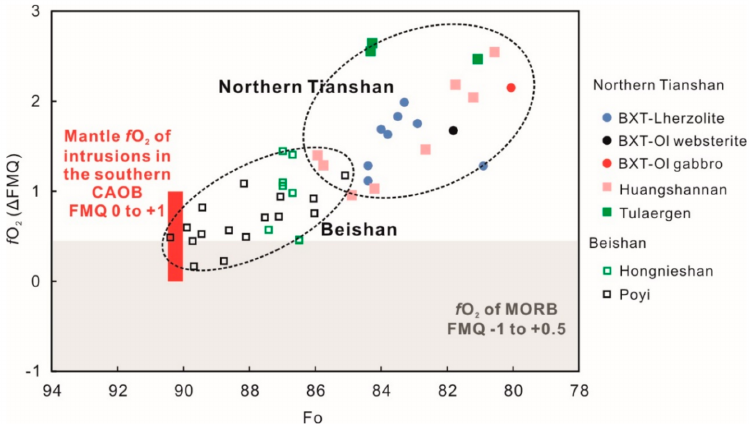
Figure 8. The estimated oxygen fugacity verse Fo value for the Baixintan and other magmatic sulfide Ni–Cu deposits in the Northern Tianshan and Beishan. Data sources: MORB [65], the mantle f O 2 of intrusions in the southern CAOB [22], Huangshannan and Tulaergen [22], Poyi [21], and Hongnieshan (unpublished data). MORB: middle ocean ridge